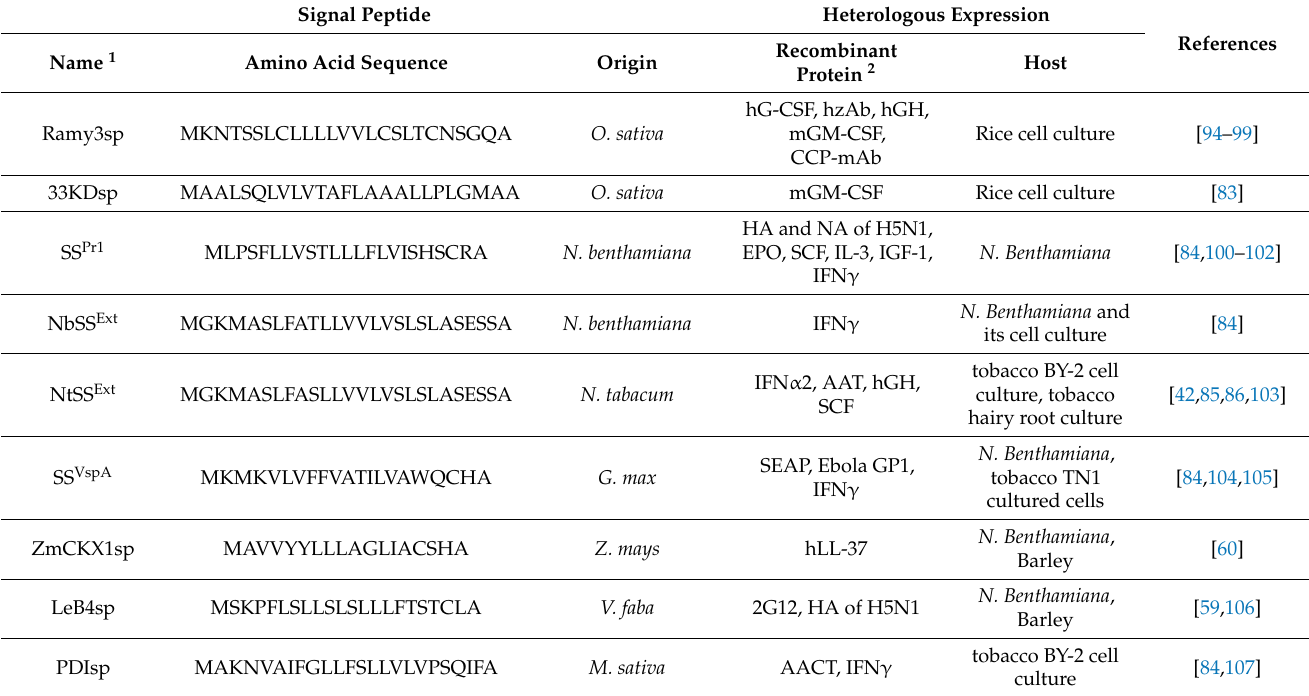
Table 2. Selected examples of signal peptide sequences used for the expression of recombinant pharmaceutical proteins in